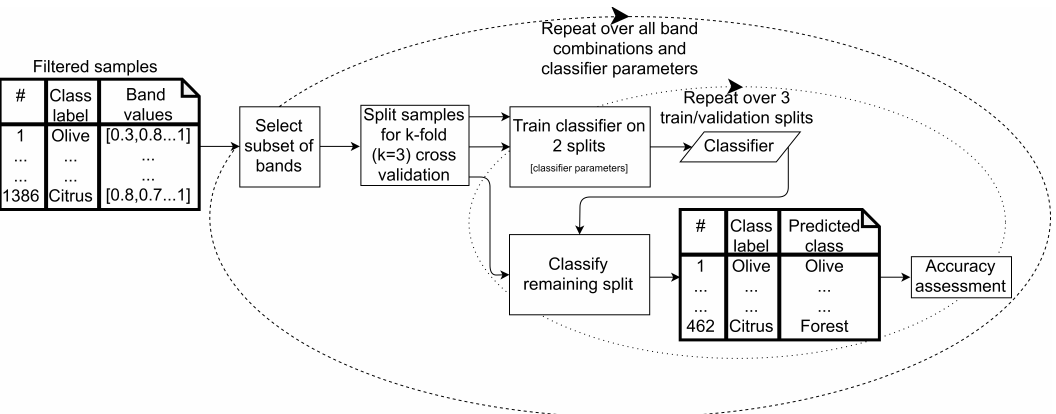
Figure 7. Selecting optimum supervised classifiers and parameters per band